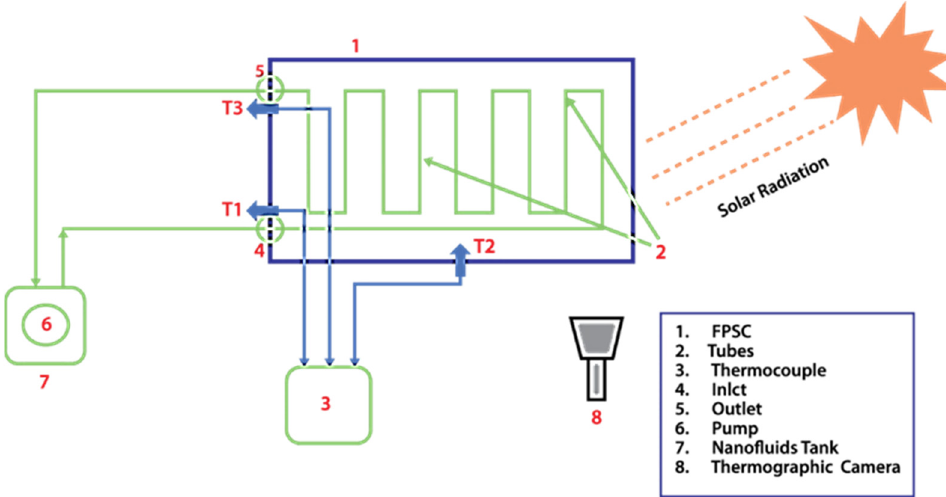
Figure 6. Arrangement of FPSC under solar radiation.